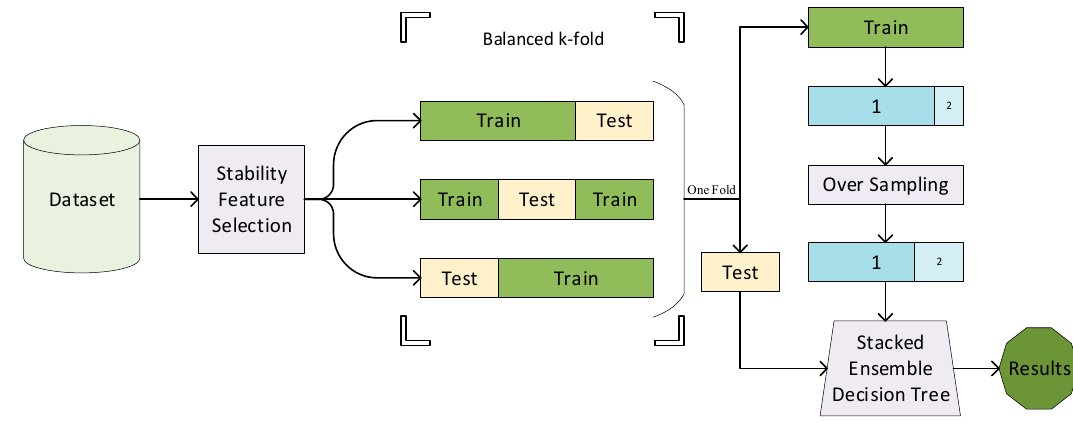
Figure 1. The block diagram of the proposed method. The features are first selected using stability feature selection. Using the stratified sampling, the features are then classified using a stacked ensemble decision tree.